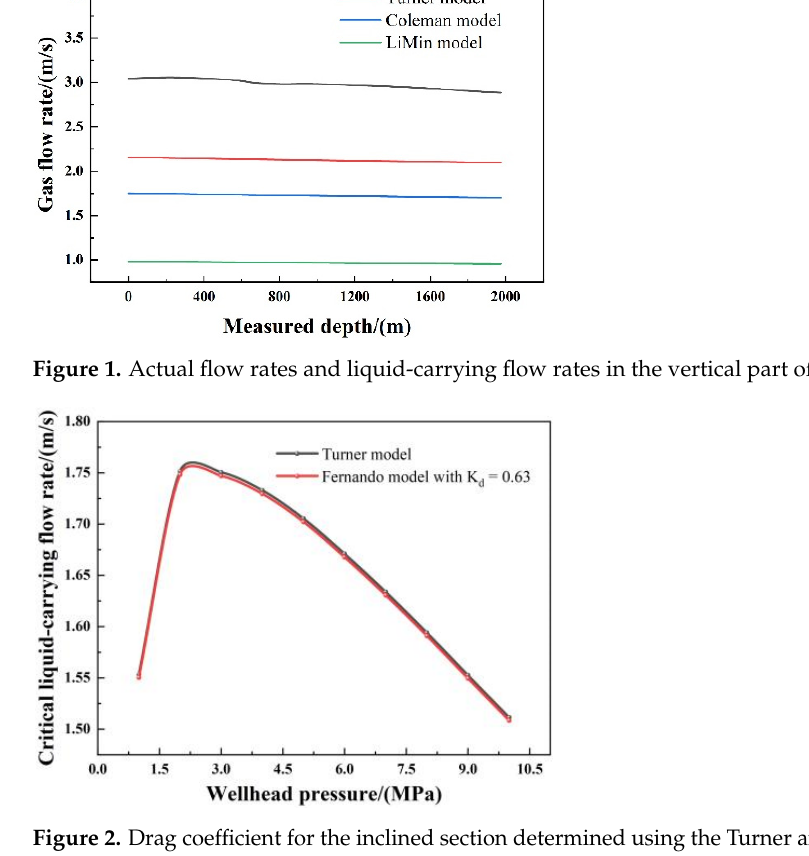
Figure 1. Actual flow rates and liquid-carrying flow rates in the vertical part of the well.